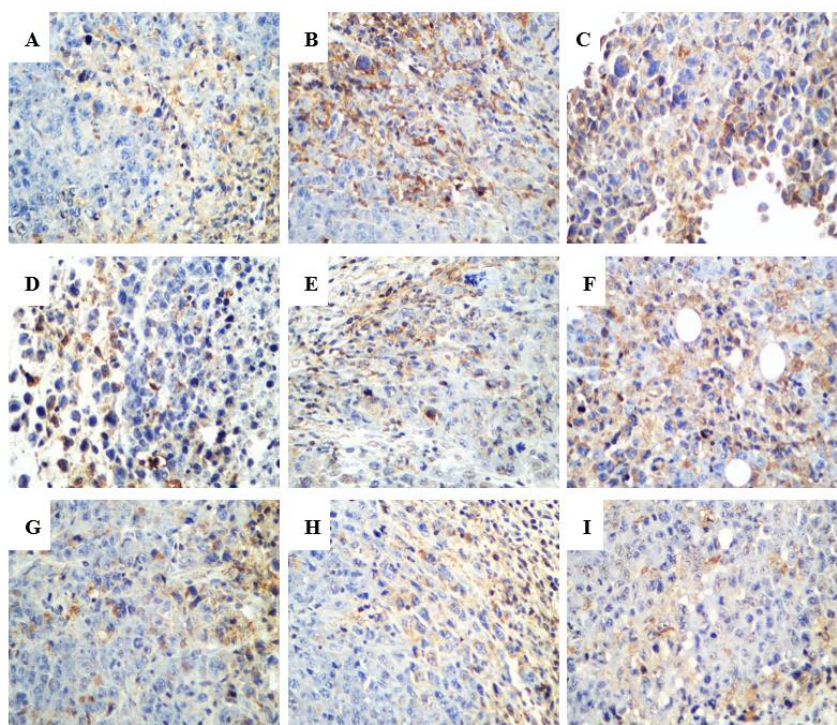
Figure 7. Representative histologic examination of morphological changes in tumors from H22-tumor bearing mice. Protein expression of Bax in H22-tumor tissues was examined by immunohistochemistry (400 × ). ( A ) model control, ( B ) CTX, ( C ) Rh 2 -H, ( D ) R-PHQ-L, ( E ) R-PHQ-M, ( F ) R-PHQ-H,